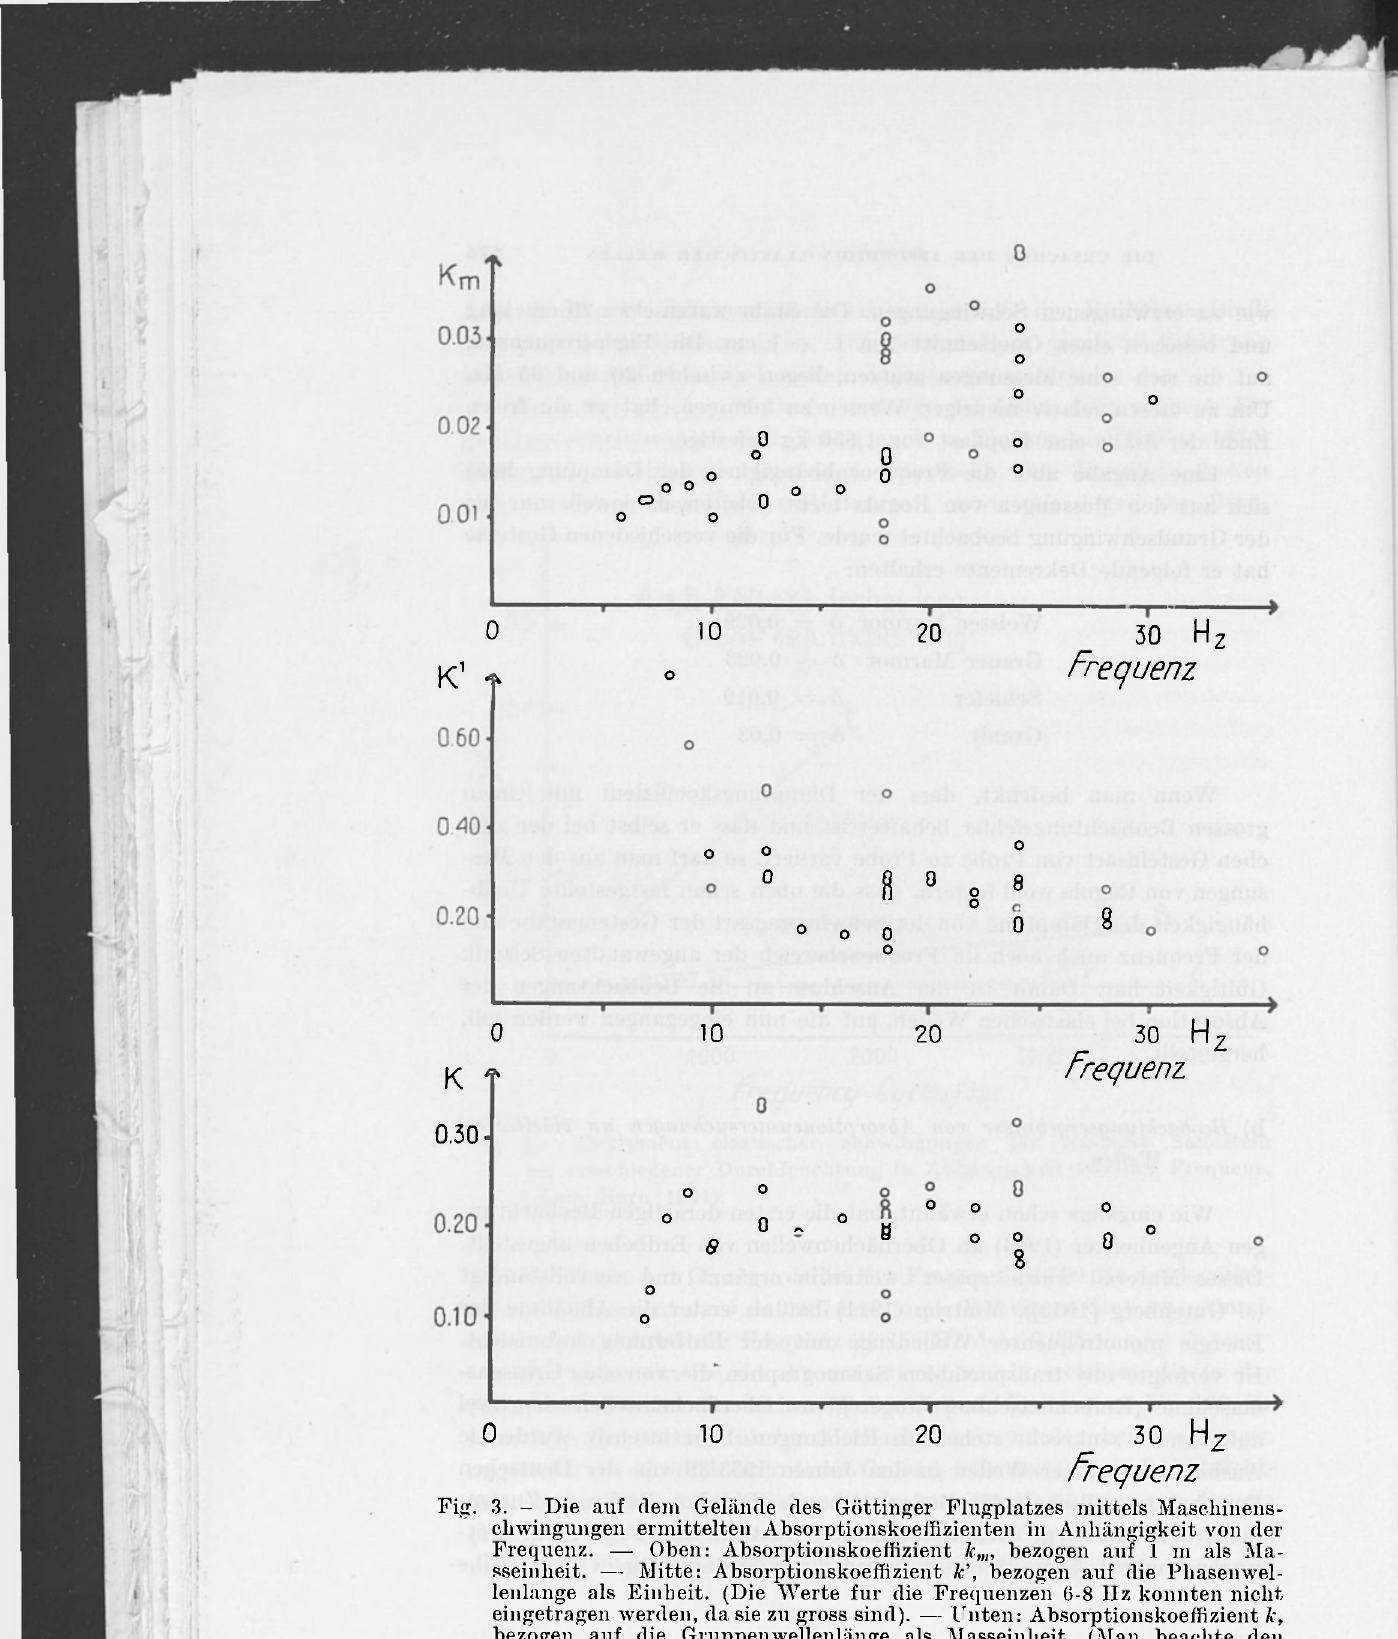
Fig. 3. - Die auf dem Gelànde des Gòttinger Flugplatzes mittels Maschinens- chwingungen ermittelten Absorptionskoeifìzienten in Anhàngigkeit von